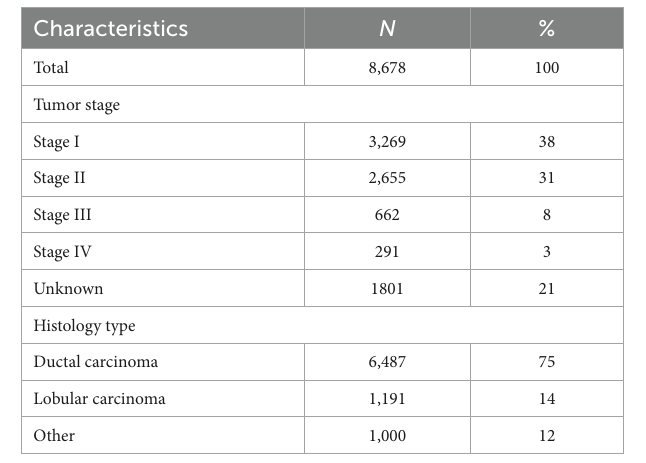
TABLE 2 Characteristics of the breast cancers.